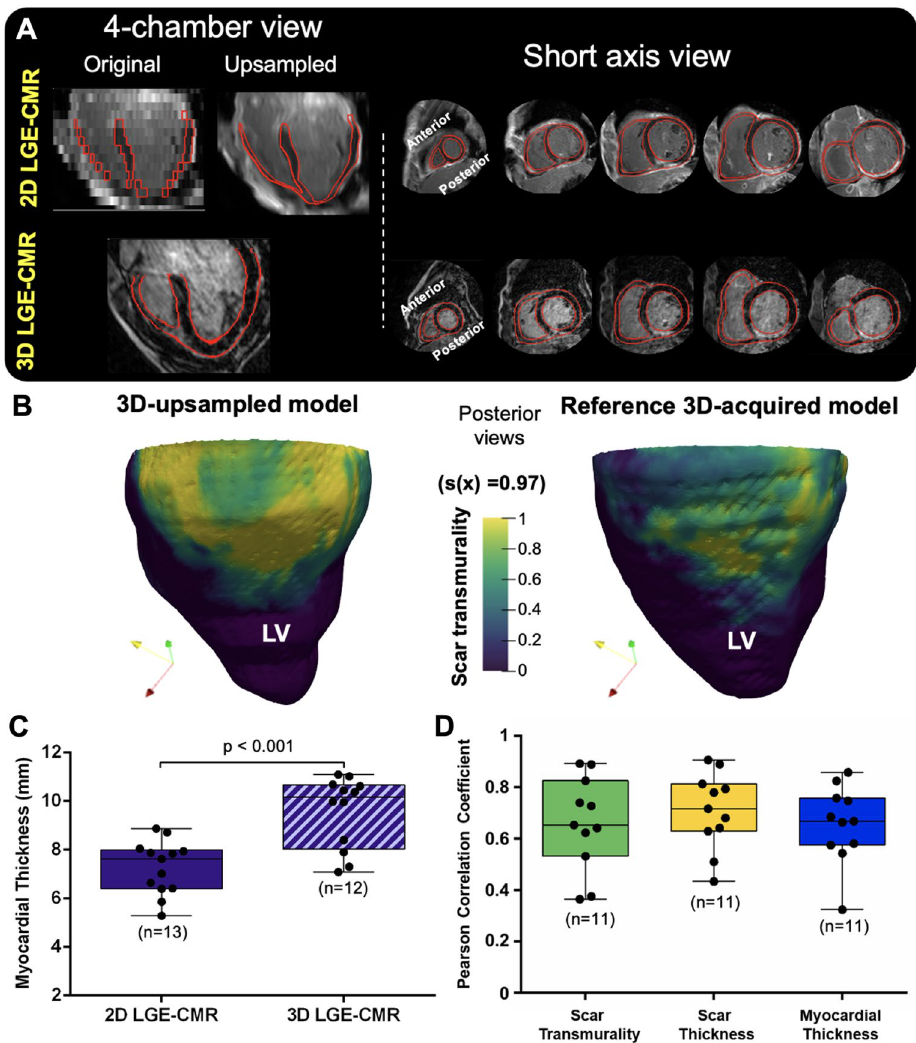
Figure 4. Three-dimensional transmural scar assessment in patients. ( A ) Long axis view of representative 3D and 2D LGE-CMR images from the same patient. ( B ) Sample scar transmurality maps from the 3D and 2D LGE-CMR images showed in ( A ). ( C ) Myocardial thickness comparison between 2D and 3D LGE-CMR images. ( D ) Pearson correlation coefficients of scar transmurality, scar thickness and myocardial thickness between 3D-acquired and 3D-upsampled models in patients. LV: left